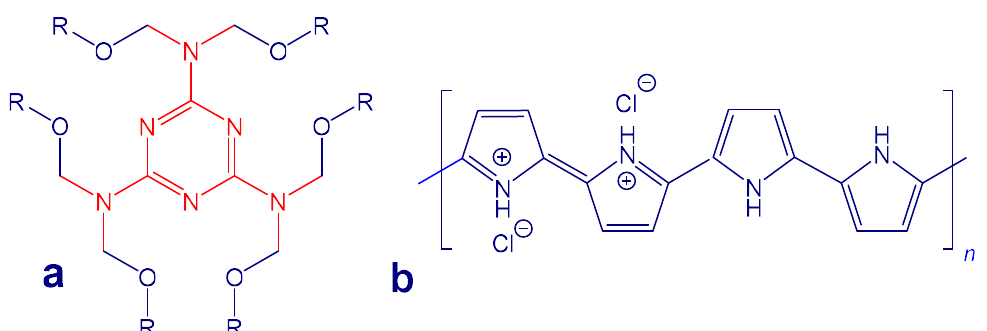
Figure 1. The molecular structure of ( a ) melamine/formaldehyde constituting the sponge, and ( b ) polypyrrole salt (hydrochloride). The melamine moiety is depicted in red; R = H or a linkage to another melamine unit.